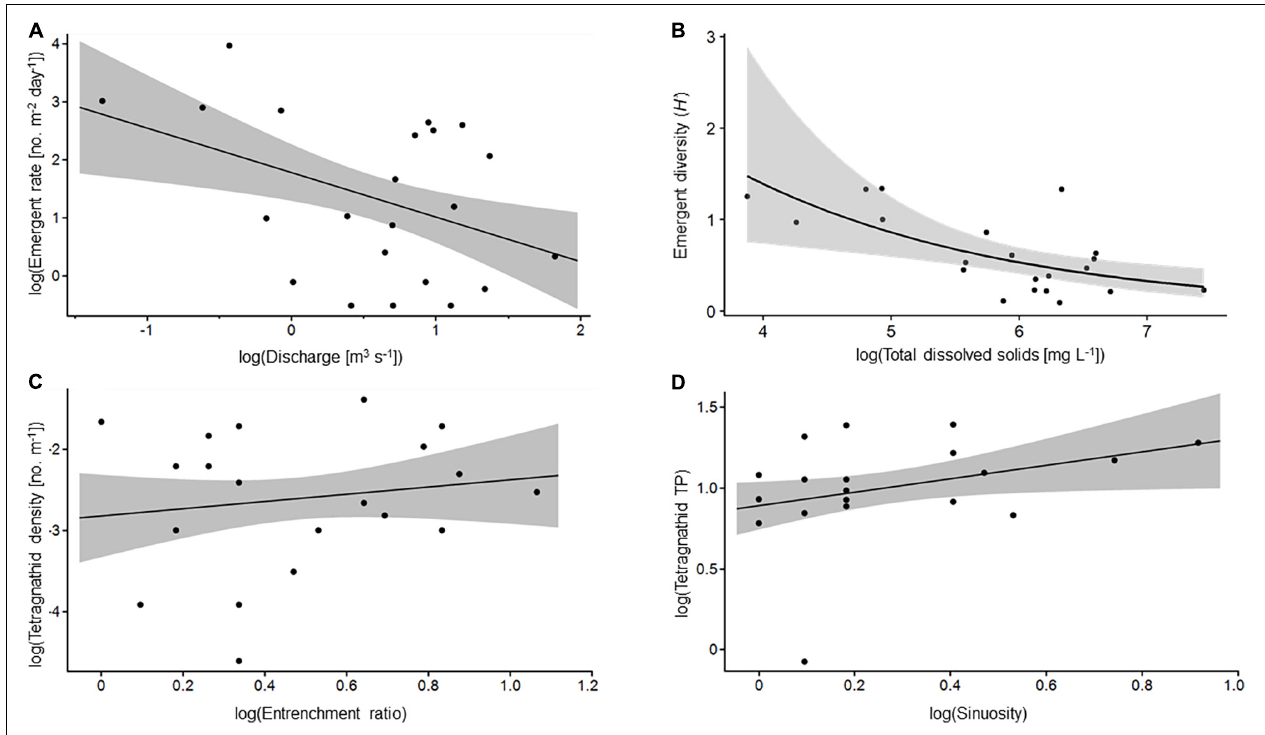
FIGURE 4 | Example bivariate relationships from models presented in Tables 2 , 3 . (A) Log bankfull discharge and log emergent aquatic insect emergence rate. (B) Log total dissolved solids and emergent aquatic insect diversity ( H’ ) on a Gamma scale. (C) Log entrenchment ratio and log tetragnathid density. (D) Log sinuosity and log tetragnathid trophic position. Shaded area indicates 95% confidence interval.